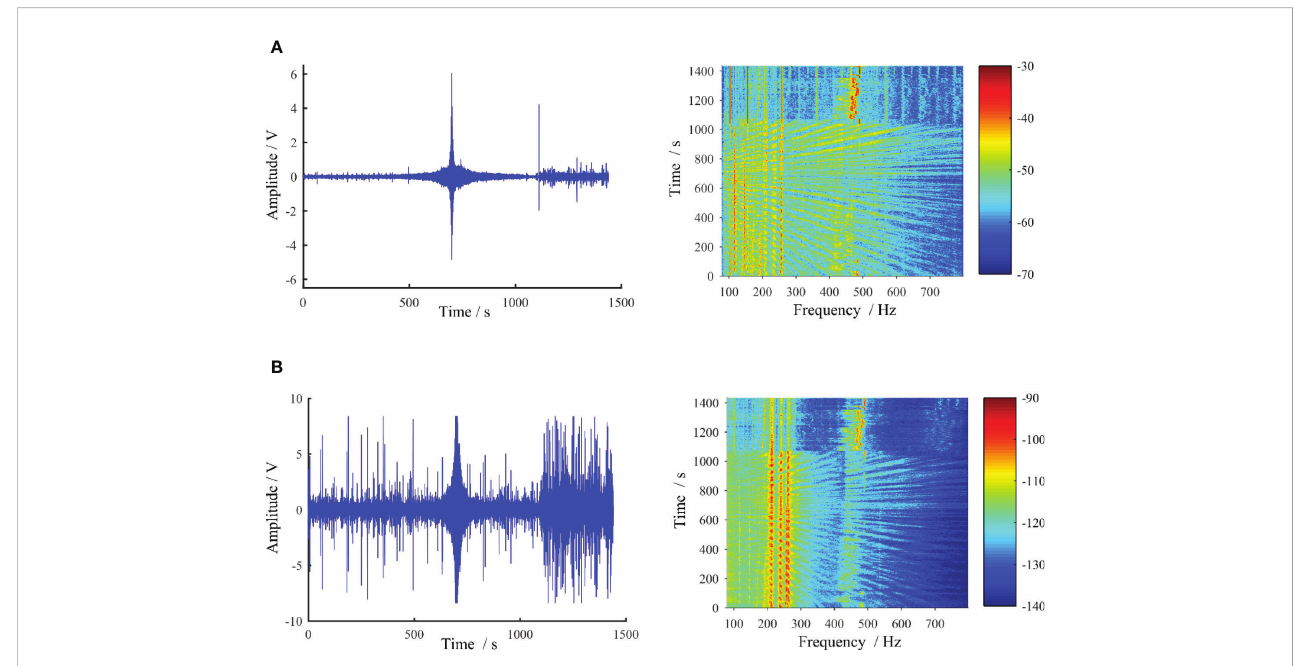
FIGURE 12 The recorded vector signals in time-domain and the corresponding LOFAR images, acoustic pressure (A) and vertical particle velocity (B) .